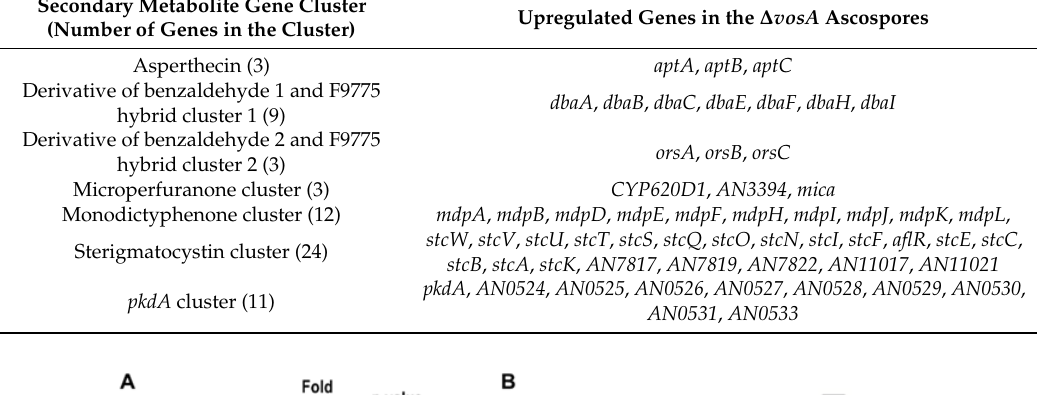
Table 2. Secondary metabolite clusters a ff ected by VosA in ascospores.